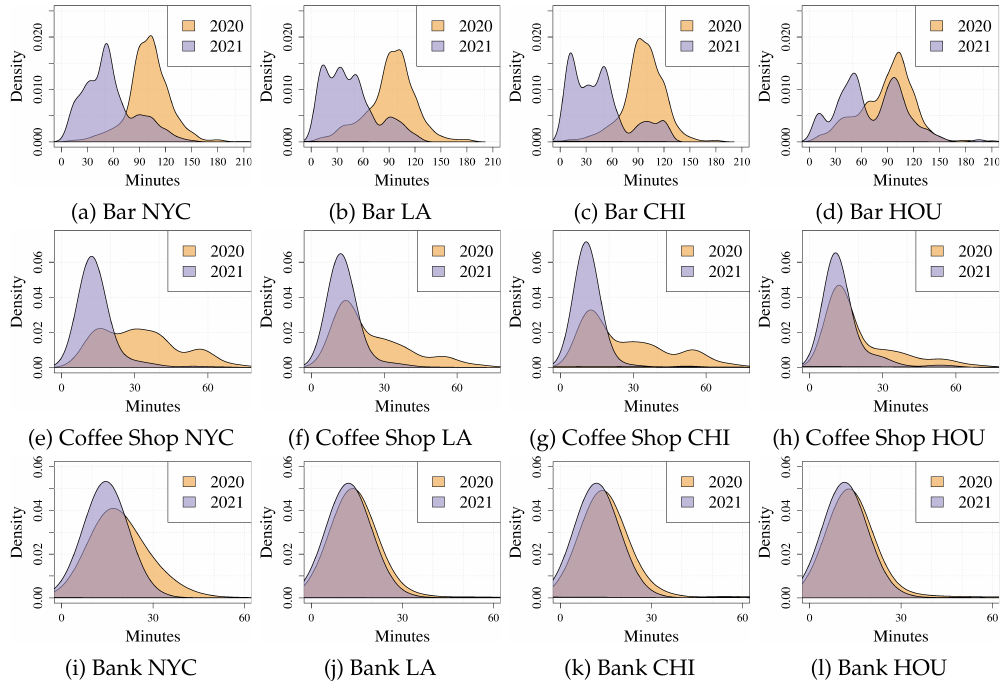
Figure 4: Density plots of visit duration for January 2020 and January 2021 split by city and place type. Bar (a-d), Coffee Shop (e-h), Bank (i-l).